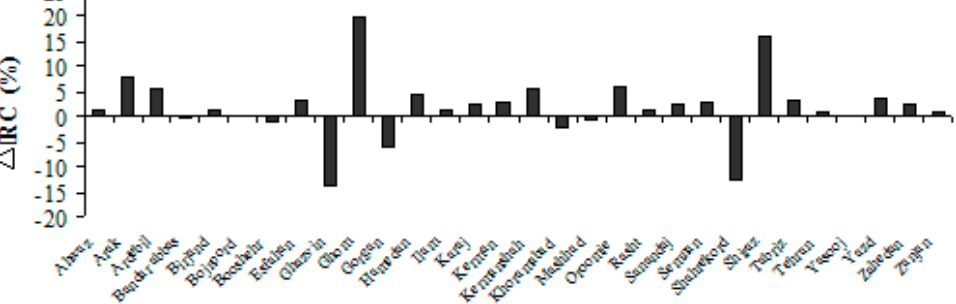
Figure 7. The change percentage of IR C predicted for the future to the base period.